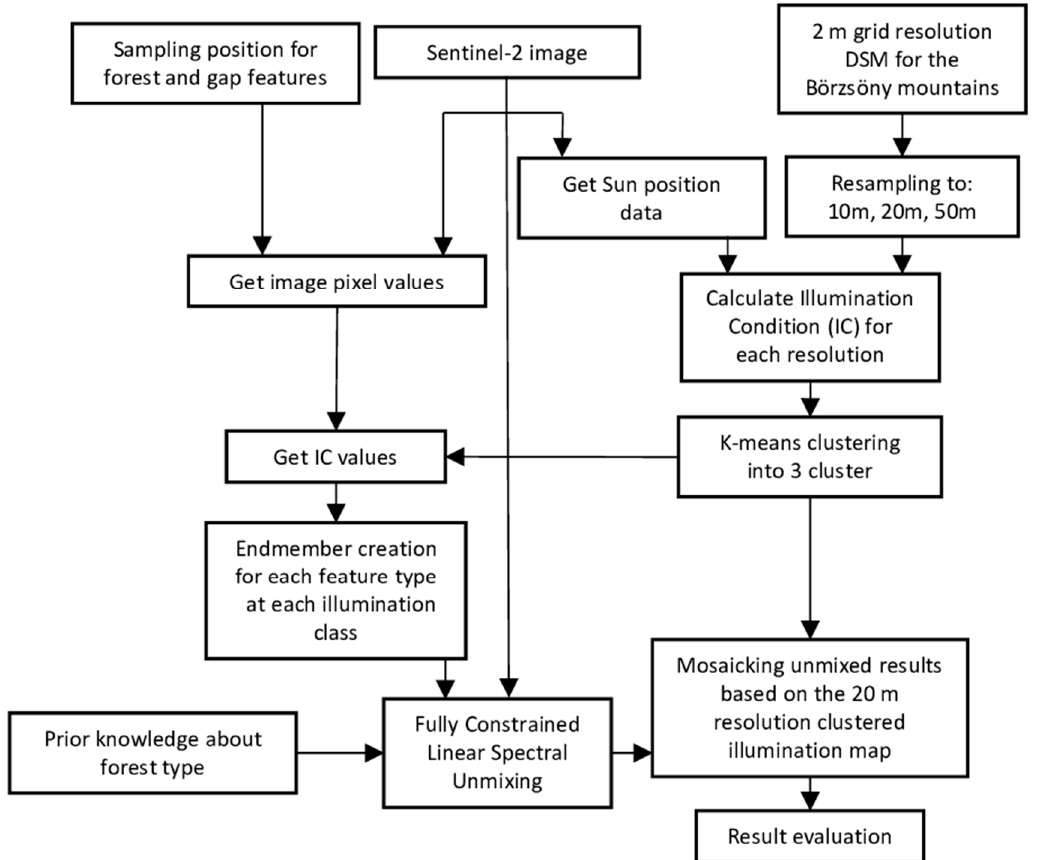
Figure 5. The workflow chart for spectral mixture analysis.